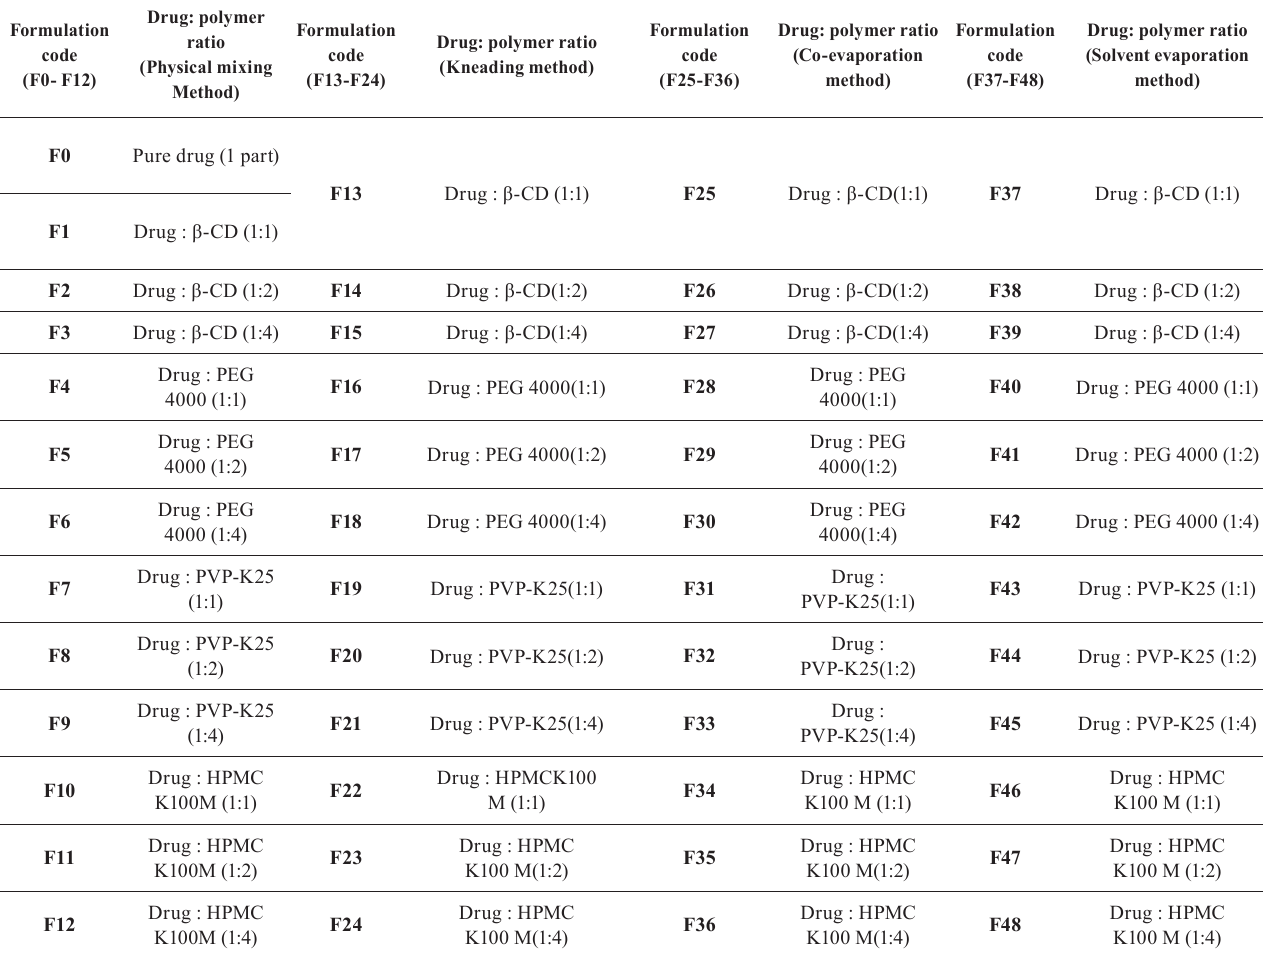
TABLE I - F ormulation design of ramipril inclusion complexes prepared by physical mixture, kneading, co-evaporation and solvent evaporation methods